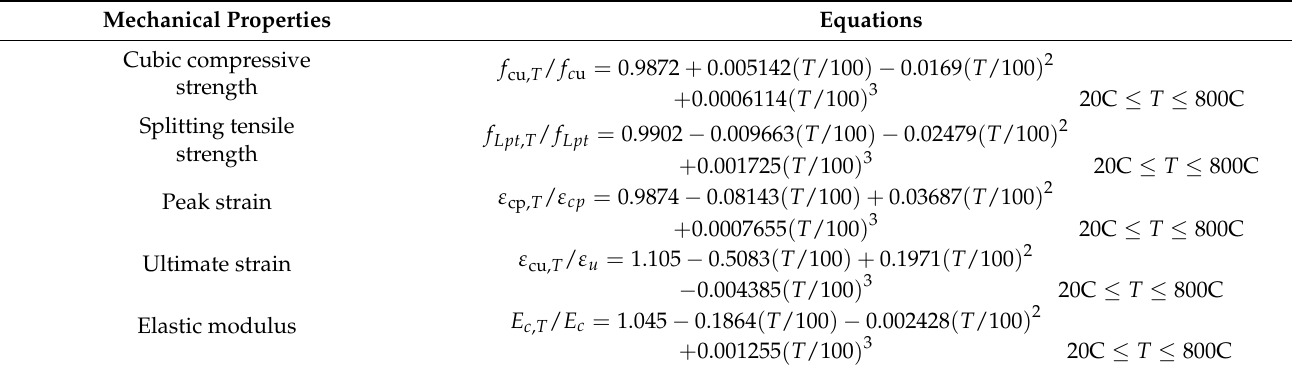
Table 2. Mechanical properties of post-fire SAC obtained by regression fitting.